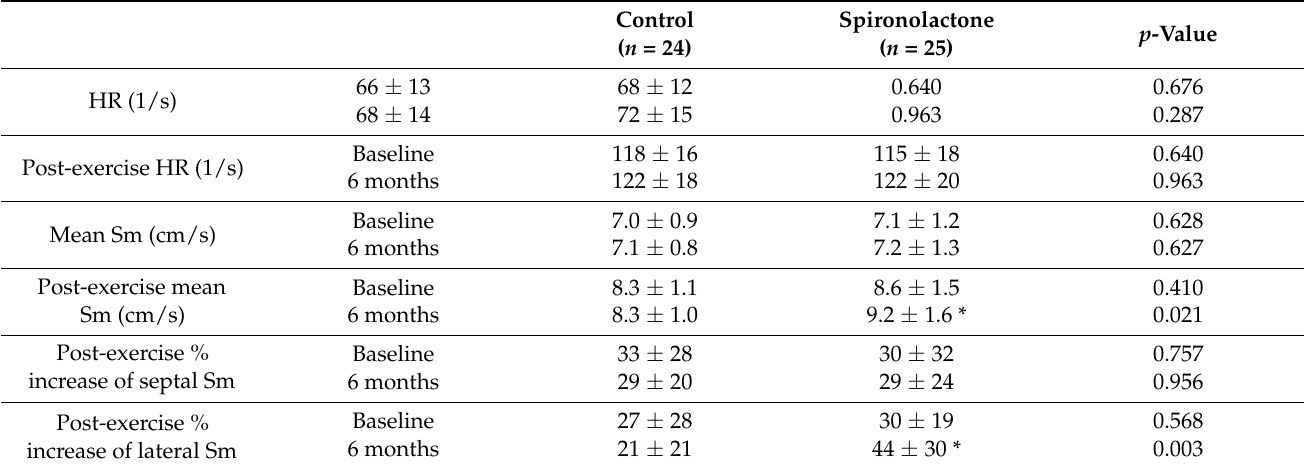
Table 3. Comparisons of Contractile Motion at baseline and 6